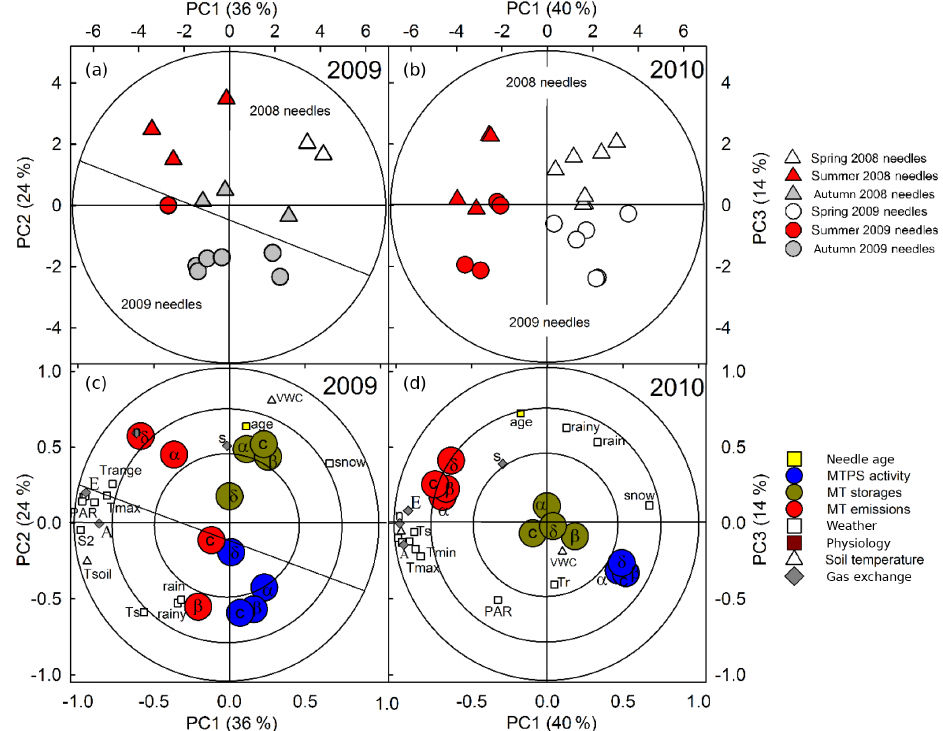
Figure 5. Two-dimensional (a–b) score plots and (c–d) scaled and centred loading plots of the PCA from monoterpene synthase activities, storage pools, emissions, and meteorological and physiological data collected in 2009 and 2010, respectively. Calculated significant principal components were validated using “full cross-validation”, with the 99% confidence levels of parameters (with seven cross-validation groups). The explained variance (as a percentage) and the number of the principal component are given in both x and y axes. The ellipses in (a) and (b) indicate the tolerance based on Hotelling’s T 2 with a significance level of 0.05. From outer to inner, the three circles in (c) and (d) indicate 100%, 75% and 50% explained variance, respectively. Lines in (a) and (c) have additionally been added to indicate the borders between the 2008 and 2009 needle samples and their respective variables. Symbol legend (a–b) : spring 1 March–15 May (white symbols), summer 16 May–14 August (red) and autumn 15 August–30 October (grey). The 2008 and 2009 needle samples are depicted with triangles and circles, respectively. α refers to α -pinene, β to β -pinene, (c) to camphene and δ to δ -3-carene. The other variables are listed in Table